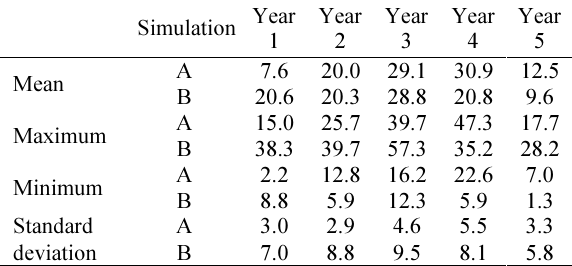
Table 3. Percentage of maintenance actions over the years